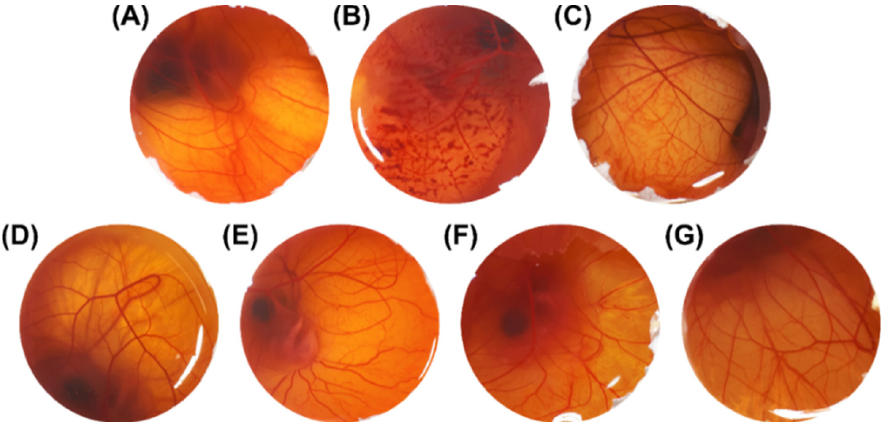
Figure 5. Images illustrating the effects of different substances applied on the chorioallantoic mem- brane over a 5 min period (1× magnification) . ( A ) NaCl 0.9% w / v , ( B ) NaOH 0.1 M, ( C ) Sodium lauryl sulfate 1% w / v , ( D ) Olive oil (negative control), ( E ) ASE solubilized in olive oil, ( F ) NE B , ( G ) NE ASE . ASE: Achyrocline satureioides extract; NE B : blank nanoemulsion; NE ASE : Achyrocline satureioides ex- tract-loaded nanoemulsion. Table 3. Irritant score and irritancy classification in the hen’s egg chorioallantoic membrane test (HET-CAM) ( n = 5).